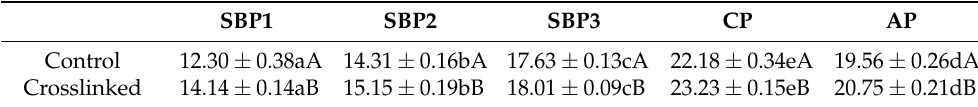
a Data are means ± standard deviations ( n = 3). Values in the same row followed by different small letters and in the same column followed by different capital letters are significantly different ( p < 0.05).